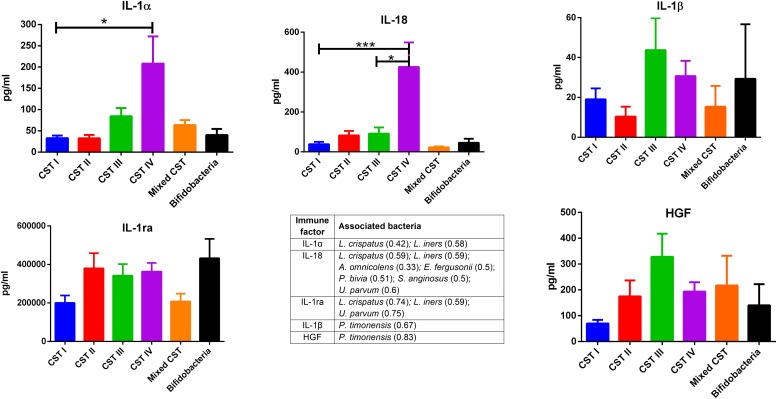
Inflammasome-dependent pathway. According to the Pearson correlation score, components belonging to the inflammasome complex significantly (FDR p-value <0.001) correlated with several microorganisms. The association was calculated by means of the observation_metadata_correlation.py script on the rarefied otu_table.biom (5,000 reads/sample). The amount of IL-1α and IL-18 varied based on the community state type (CST). The comparisons were performed by means of a Kruskal–Wallis one-way analysis of variance. When a significant p-value was observed (p < 0.05), a multiple comparison test was used to determine which groups were different. The data are shown as the mean value ± standard error of the mean (SEM). Pearson scores for every bacterial species are shown in brackets. FDR, false discovery rate. ∗p < 0.05, ∗∗∗p < 0.001.